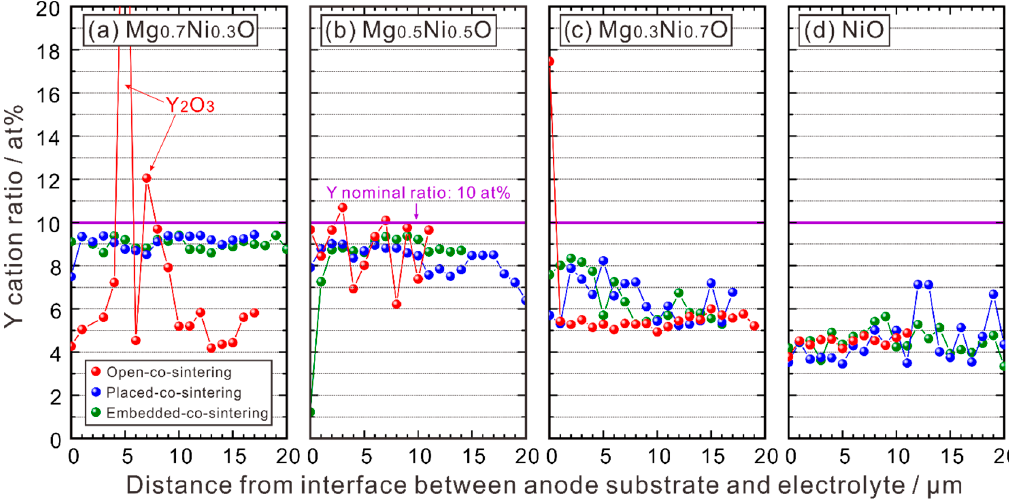
Figure 5. Y cation ratio in the electrolyte layer of the half cells with the anode substrates of ( a ) BZY20-50 wt % Mg 0.7 Ni 0.3 O, ( b ) BZY20-50 wt % Mg 0.5 Ni 0.5 O, ( c ) BZY20-50 wt % Mg 0.3 Ni 0.7 O, and ( d ) BZY20-50 wt % NiO. All the half cells were co-sintered at 1600 ° C in oxygen for 10 h with the method shown in Figure 1. The Y cation ratio was measured with EPMA-WDS line analysis following the position shown in Figure 2 (red line) from the interface between the anode substrate and the electrolyte.